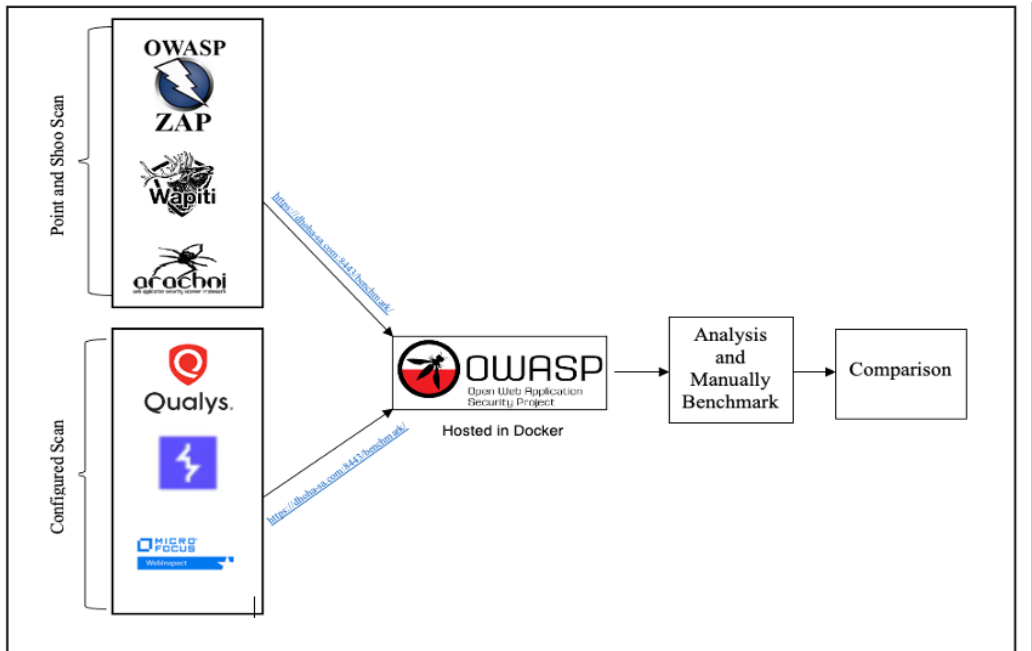
Figure 3. Implementation